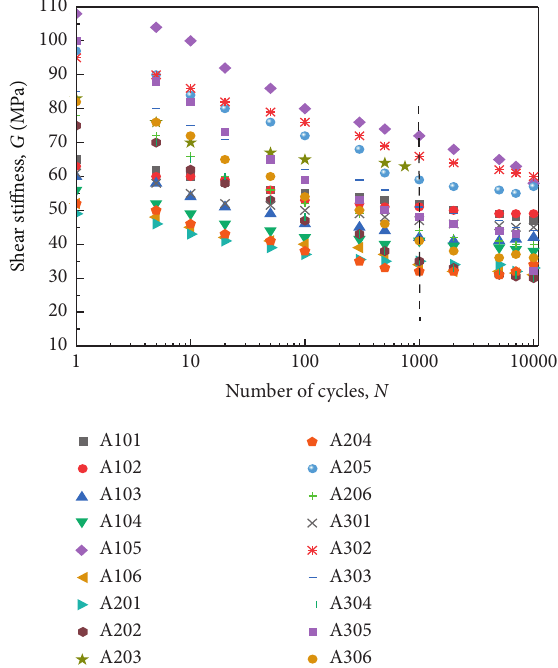
Figure 5: Relationship between shear stiffness and cycle